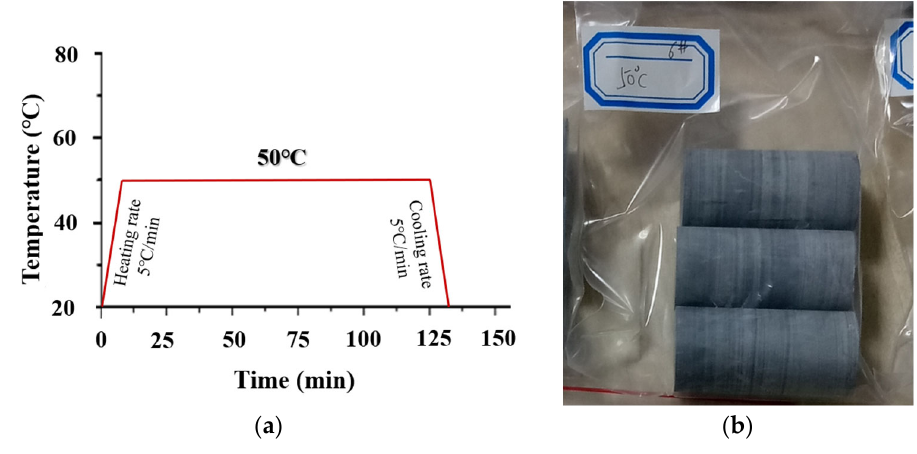
Figure 4. Temperature treatment process of shale samples. ( a ) The heating path of the shale and